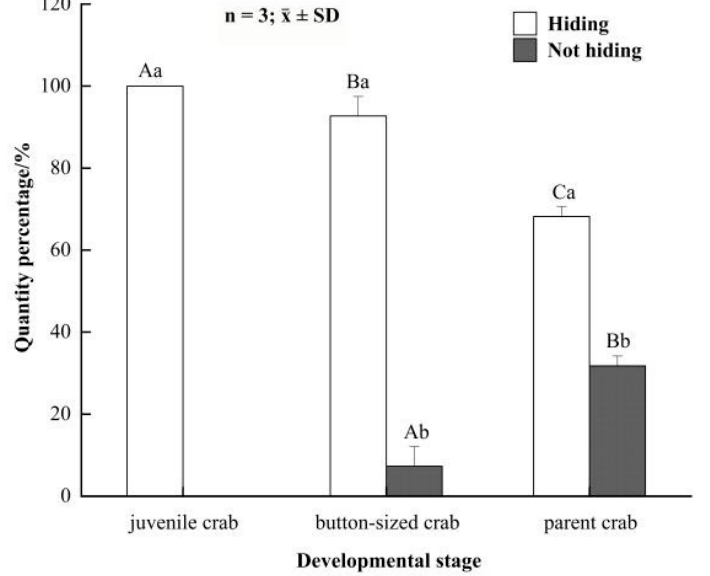
Figure 2. The hiding rate of Eriocheir sinensis in different developmental stages. Bars with same letters on the top indicate they have insignificant differences ( p > 0.05), and bars with different letters on the top indicate they have significant differences ( p < 0.05). Capital letters indicate the significance of hiding rates in different developmental stages, and lowercase letters indicate the significance of hiding and not hiding in the same stage.